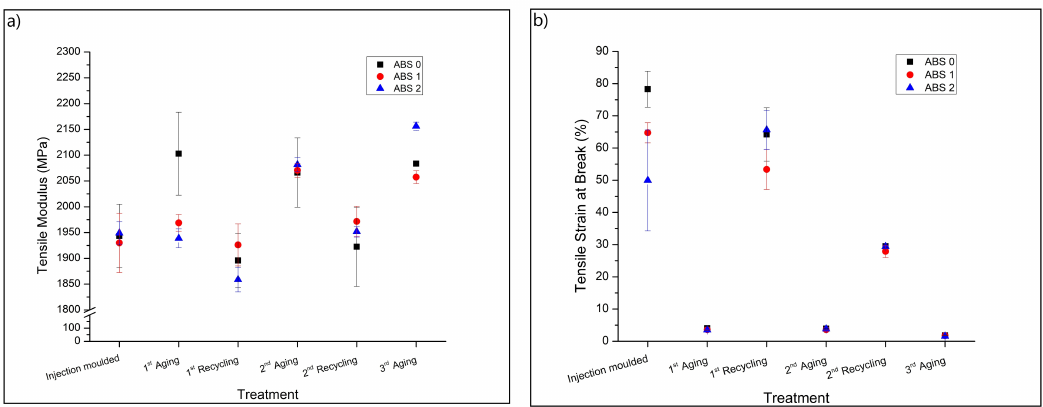
Figure 5. Tensile properties of the samples. ( a ) Tensile modulus, and ( b ) strain at